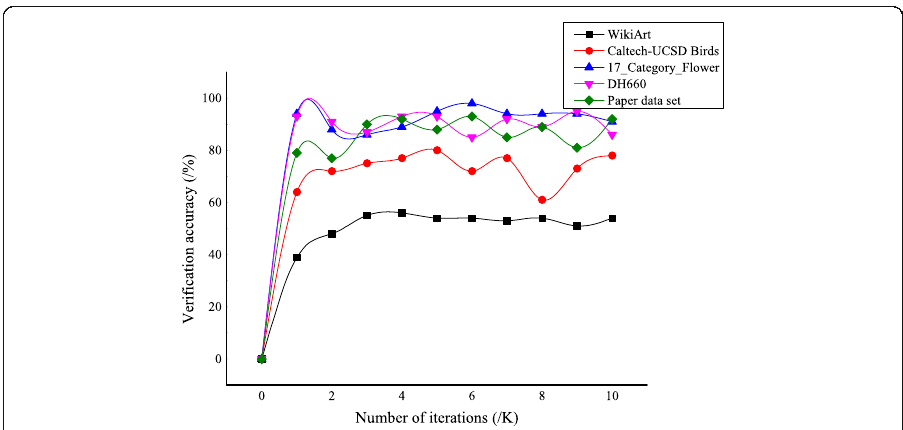
Fig. 16 Comparison of experimental accuracy among different